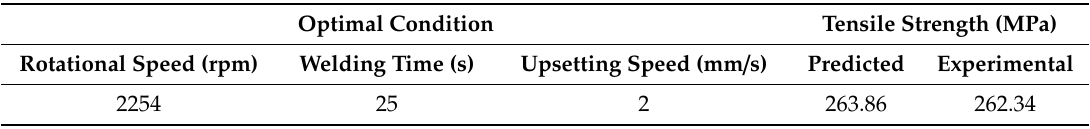
Table 6. Optimum conditions and predicted and experimental